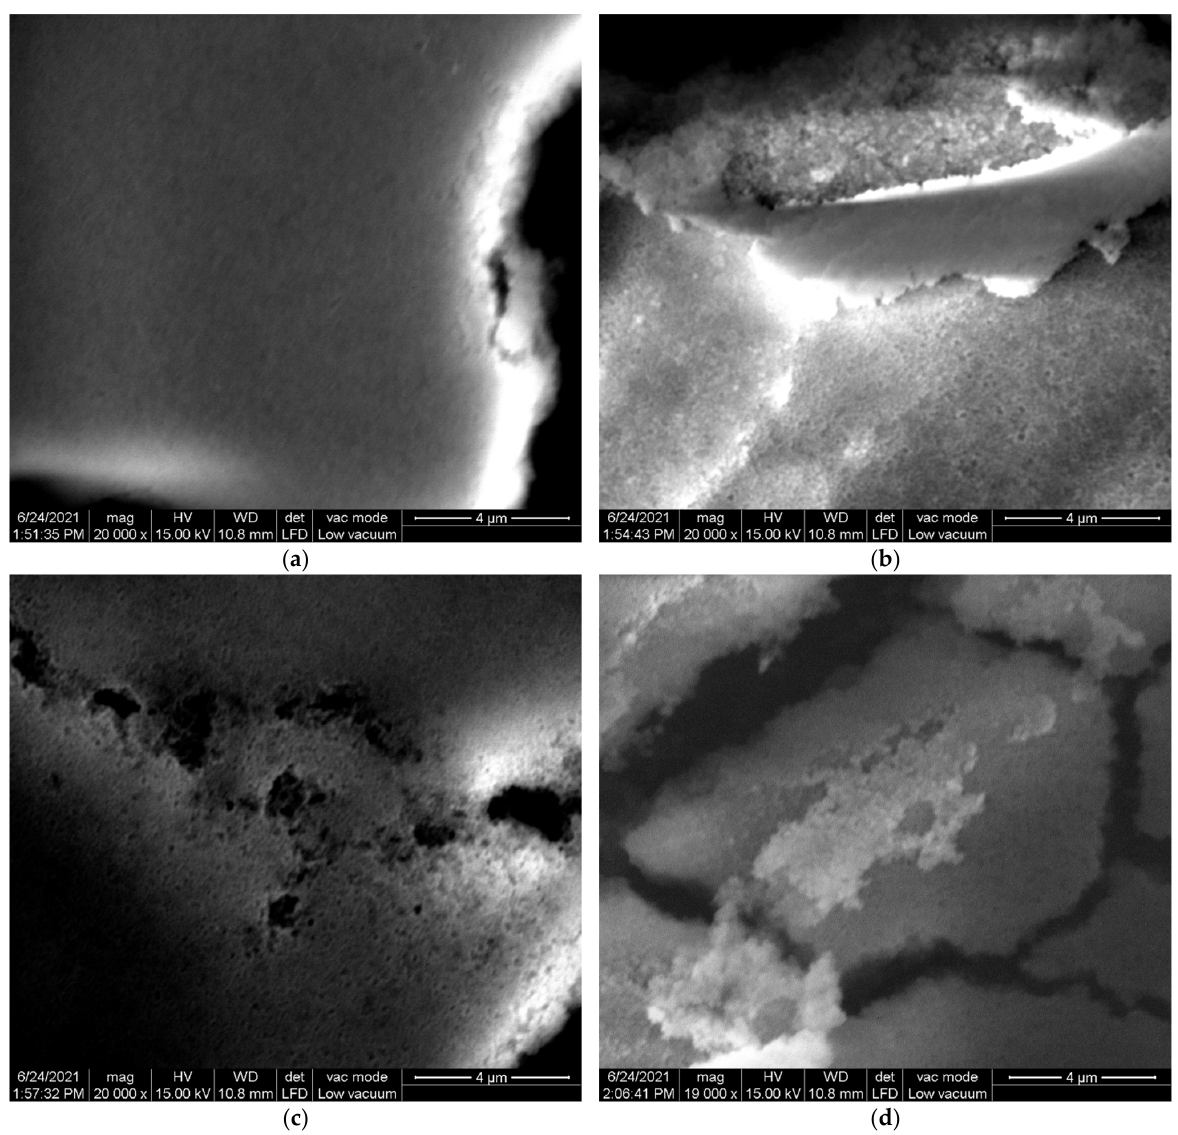
Figure 4. SEM image of silica and organically modified silica prepared at TEOS:NH 4 OH:H 2 O ratio of 1:3.4:15.2. SiO 2 -1 ( a ),